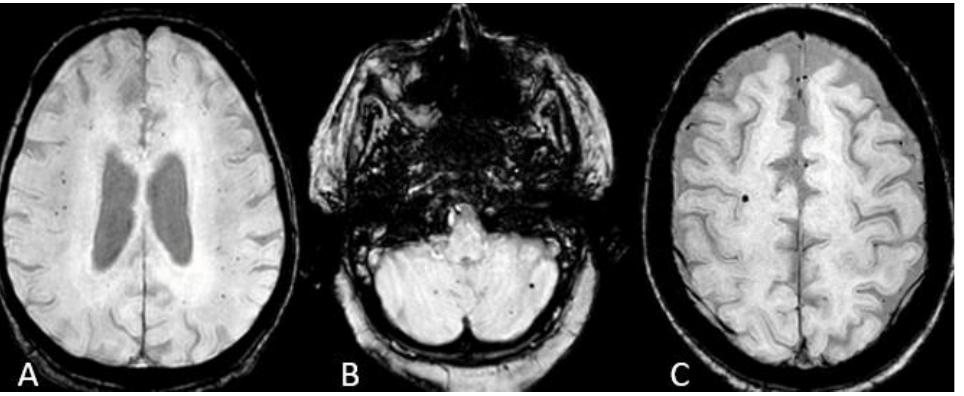
Figure 3. Microhemorrhages. ( A ) SWI images show the diffuse pattern of microhemorrhages. ( B ) Isolated cerebellar microhemorrhages. ( C ) Isolated frontal microhemorrhage. FLAIR hyperintensities in the medial temporal lobes were the third most common presentation reported in 12 patients (30%). These findings were bilateral in 10 patients (25%) (Figure 4A) and isolated left-sided in 2 patients (5%) (Figure 4B). We did not detect isolated right temporal FLAIR hyperintensities. FLAIR hyperintensities in the posterior fossa were the fourth most common manifestation of COVID-19-associated encephalitis evident in 9 patients (20%), which in 6 of them effected the ventral pons (15%) (Figure 5A), bilateral middle cerebellar peduncles in 1 patient (Figure 5B), vermis in 1 patient (Figure 5C), and bilateral cerebellar hemispheres in 1 patient (Figure 5D). FLAIR hyperintensities in the basal ganglia and thalami were the fifth most common finding evident in 6 patients (15%), with a bilateral involvement pattern in 4 patients (10%) (Figure 6A), and isolated bilateral thalami findings in 2 patients (5%) (Figure 6B).